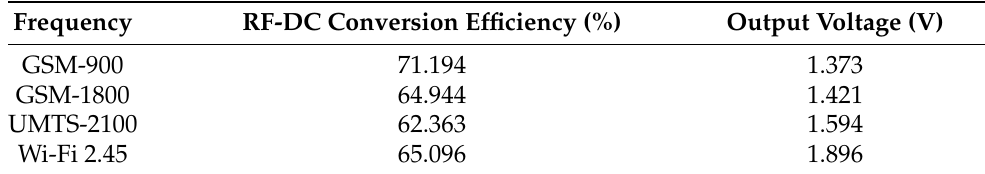
Figure 17. Output voltage of the proposed quad-band circuit with four receiving antennas for the load of 5 k Ω . Table 3. Recorded results for the second scenario under 0